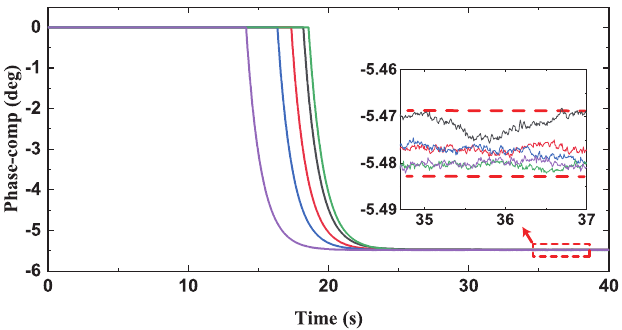
Figure 13. The five times measured results of the compensation